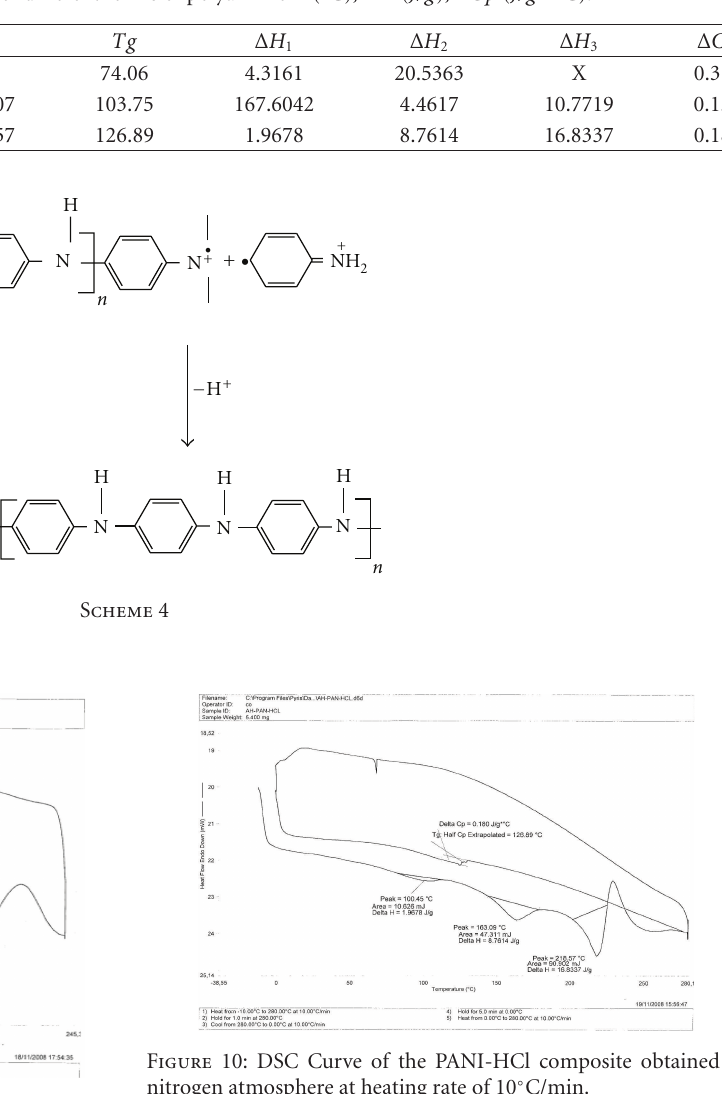
Figure 8: Typical DSC thermogram on annealed polyaniline (PANI-EB) obtained in the glass transition region at a heating rate of 10 ◦ C/min.